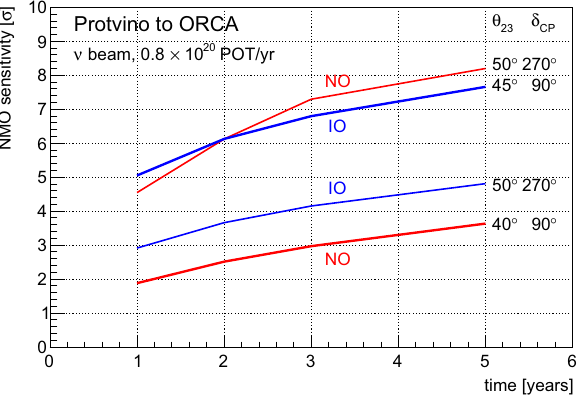
Fig. 9 Sensitivity of P2O to neutrino mass ordering as a function of the accumulated exposure time with the 90 kW beam (positive beam polarity). For both normal and inverted ordering, the most and the least favourable scenarios are